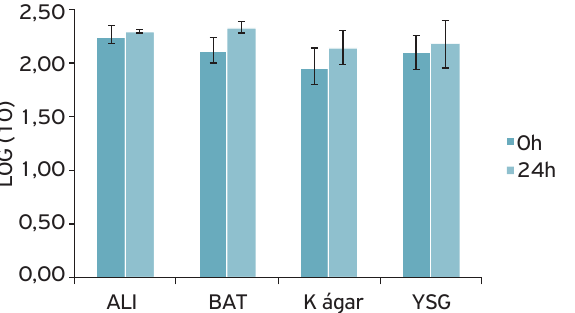
CFU/mL).8 Figure 1. Recovery results of reference strains and pasteurized orange juice isolates (log Figure 2. Results of Alicyclobacillus acidoterrestris growth Figure 3. Results of Alicyclobacillus acidoterrestris growth with with enrichment in reconstituted orange juice plated with the enrichment in reconstituted orange juice plated with the deep surface method at 0h and 24 hours (log method at 0 and 24 hours